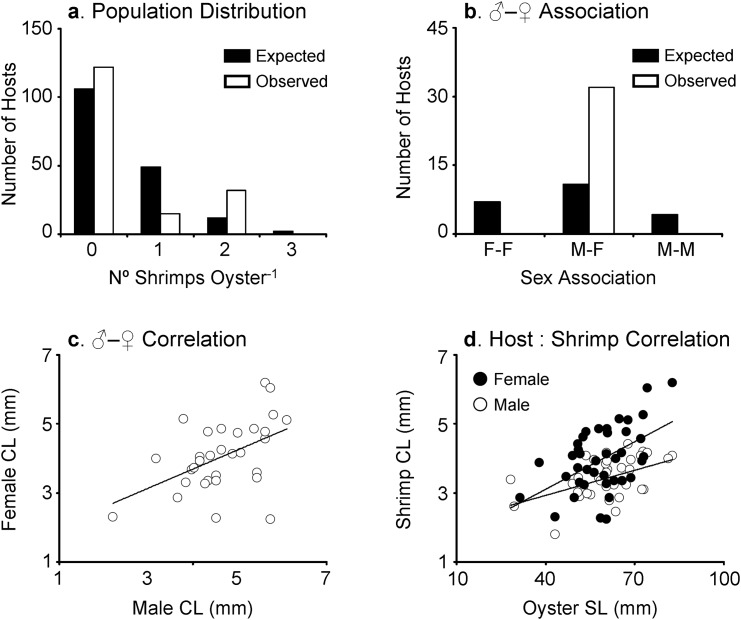
Host use pattern of Pontonia manningi (combined data from the three sampling sites) at Long Key Reef tract, Florida Keys, USA.(a) Population distribution of Pontonia manningi. Observed frequency of shrimps on hosts differed significantly from an expected Poisson random distribution. (b) Male-female association pattern of Pontonia manningi found as pairs inside the mantle cavity of the Atlantic winged oyster Pteria colymbus. Observed frequency of heterosexual pairs differed significantly from the expected binomial random distribution. (c) Relationship between carapace length (CL) of males and females of Pontonia manningi found as pairs inside the mantle cavity of the Atlantic winged oyster Pteria colymbus. (d) Relationship between carapace length (CL) of males or females of Pontonia manningi and shell length of the Atlantic winged oyster Pteria colymbus. See results for further details.